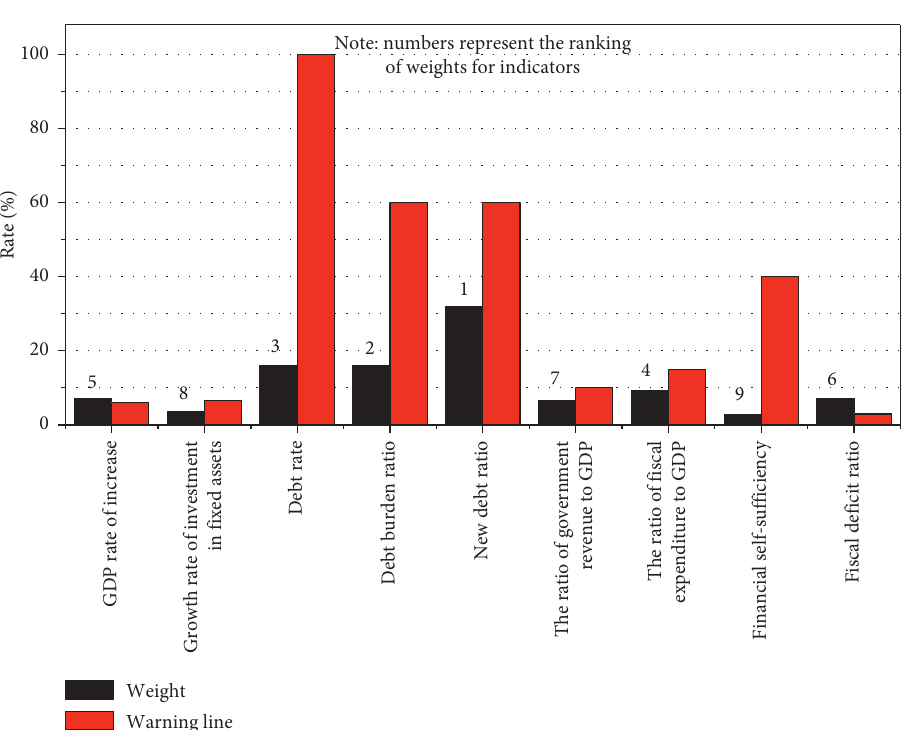
Figure 4: The weight and ranking of risk factors affecting government